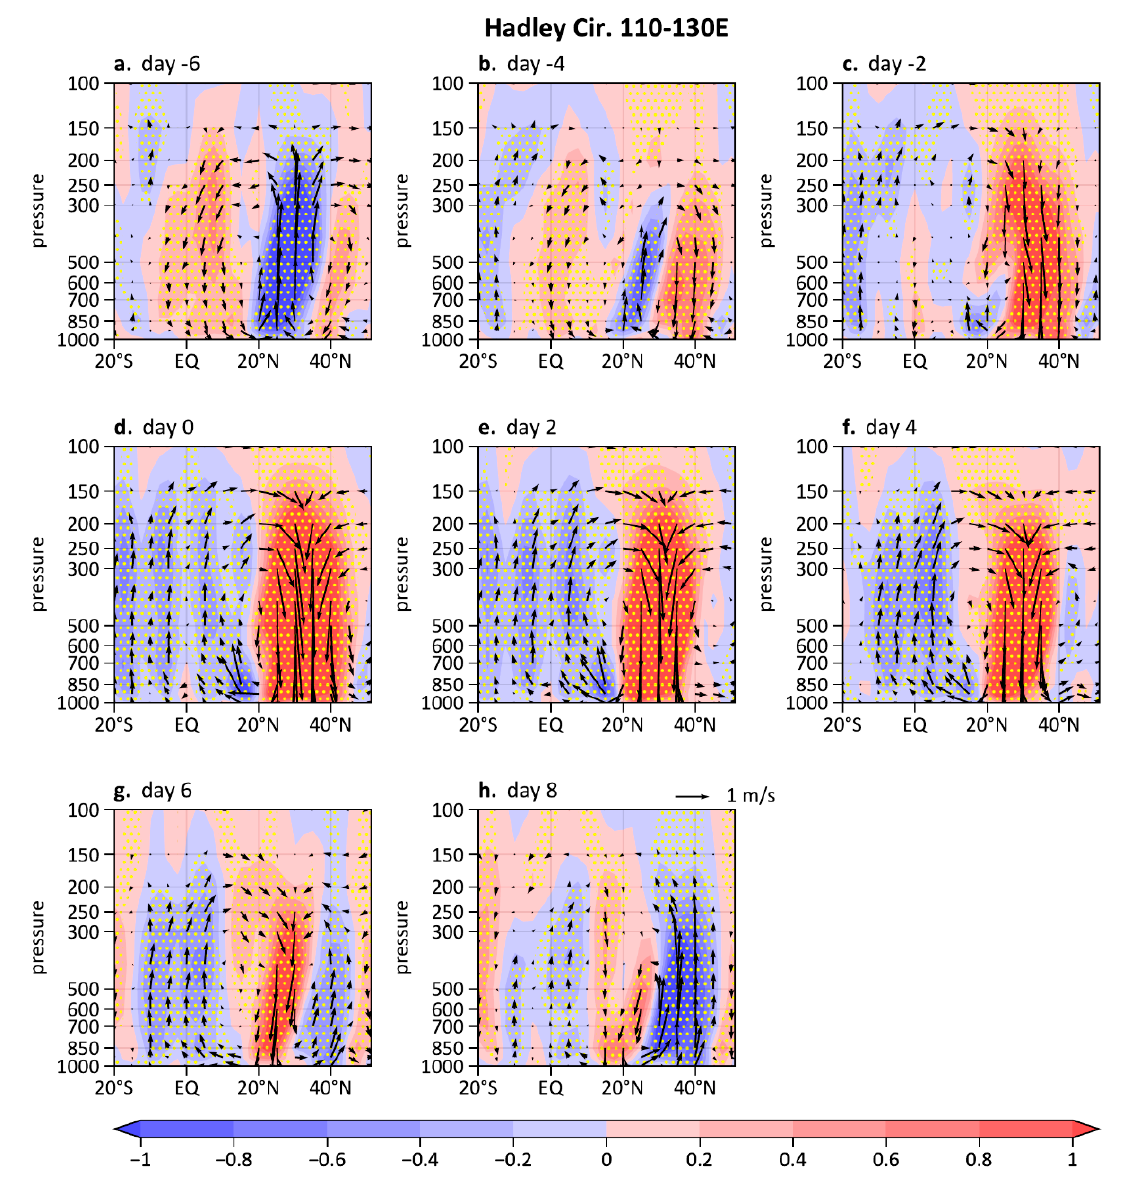
Figure 8. ( a – h ) Composite anomalies of vertical p -velocity (color shading, 0.01 Pa s − 1 ) and divergent meridional wind (m s − 1 ) along 110° − 130°E at days − 6 to 8 and with an interval of 2-days during the strong EAWM events. Stripping regions indicate the p -velocity anomalies exceed the 95% confidence level.